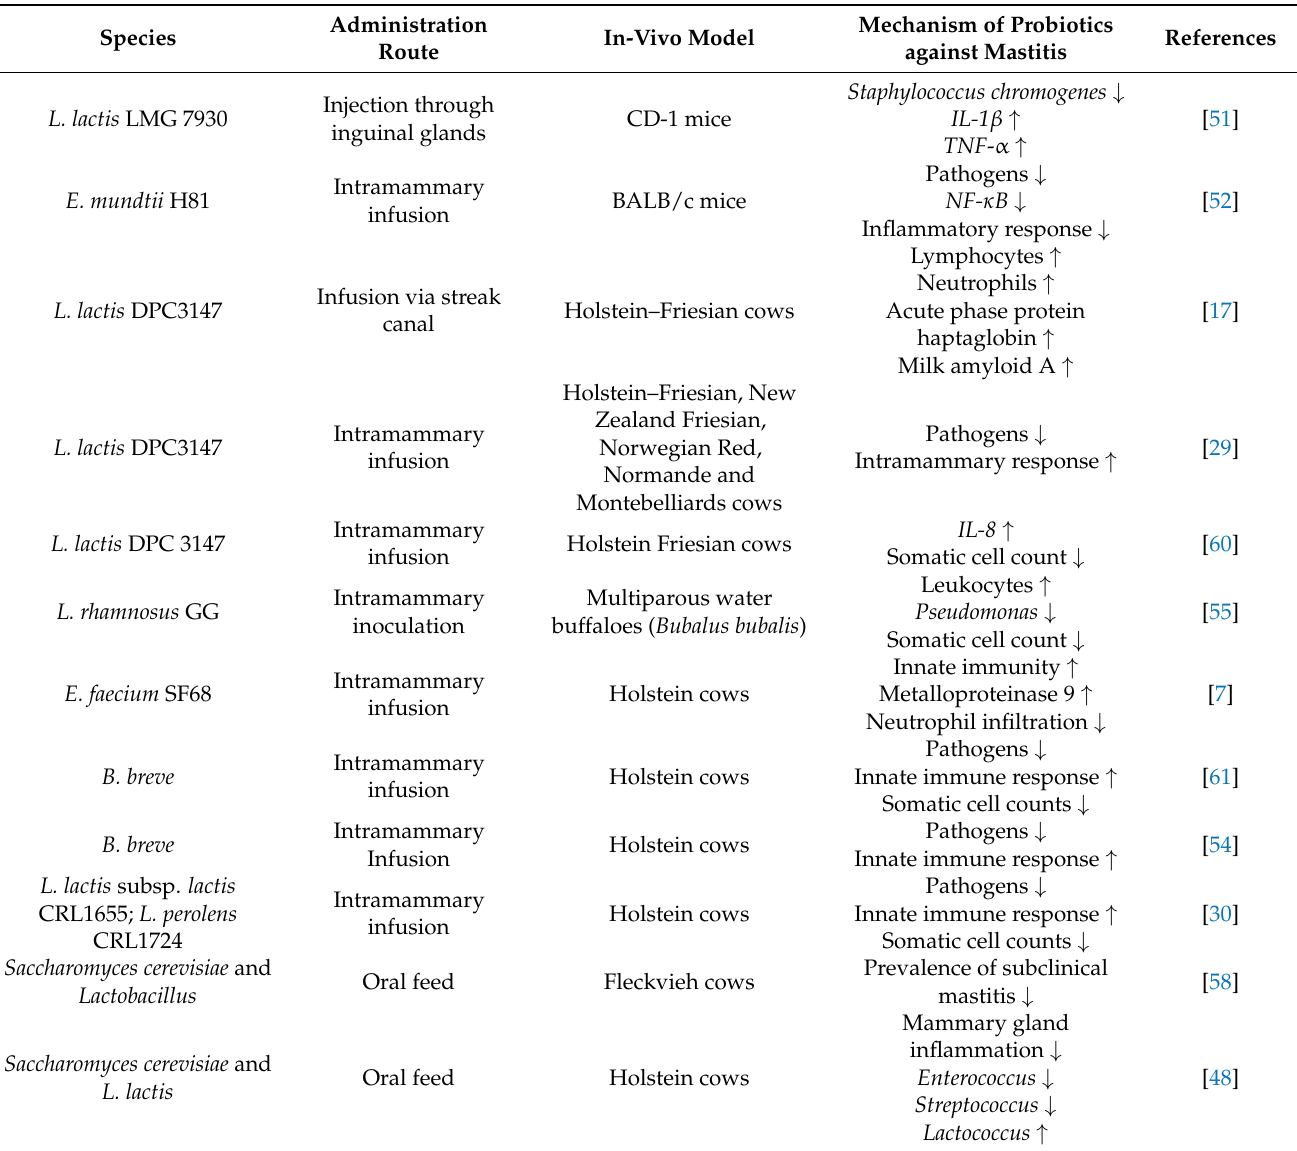
Table 1. Summary of in vivo studies of probiotics against bovine